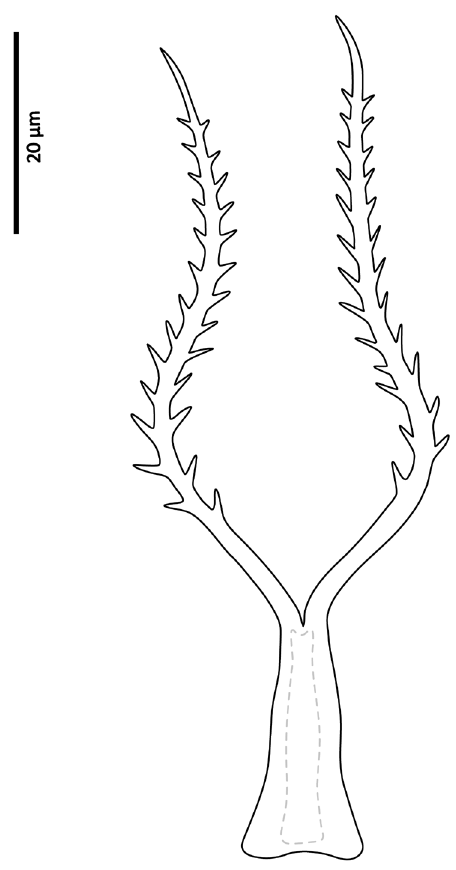
Figure 18. Zygoseius lindquisti sp. n., female, tritosternum. smooth; setae JV2 slightly longer than other setae; other setae subequal, except ZV1 shorter (Table 1); para-anal setae inserted at level of anterior margin of anal opening; gland openings gv3 on posterolateral margins of shield at level of posterior margin of anus; cribrum well-developed, 2–3 rows of spicules, extending along posterior shield margin between gv3 openings; anal opening 25–26 long, 21–22 wide, subtriangular to subcircular, located in posterior fifth or fourth of shield. Peritreme 191–198 long, densely covered with aciculae, extending anteriorly near seta z1 , with one gland pore ( gp ) at mid-level of coxa II. Peritrematal shield wide, fused to exopodal, parapodal and metapodal elements, extending well behind posterior level of coxae IV; shield micropunctate, with larger punctae in poststigmatic region, with four pore-like struc- tures ( id3 , gd3 , id7 , gv2 ). Exopodal element between coxae II–III fused with other exopodal-peritrematal elements (Fig. 19). Soft lateral and opisthogastric integument plicate, bearing nine pairs of setae, 15–30 long, slightly thickened basally, marginal setae as the longest. Soft cuticle with five pairs of poroids, including four ivo , idR3